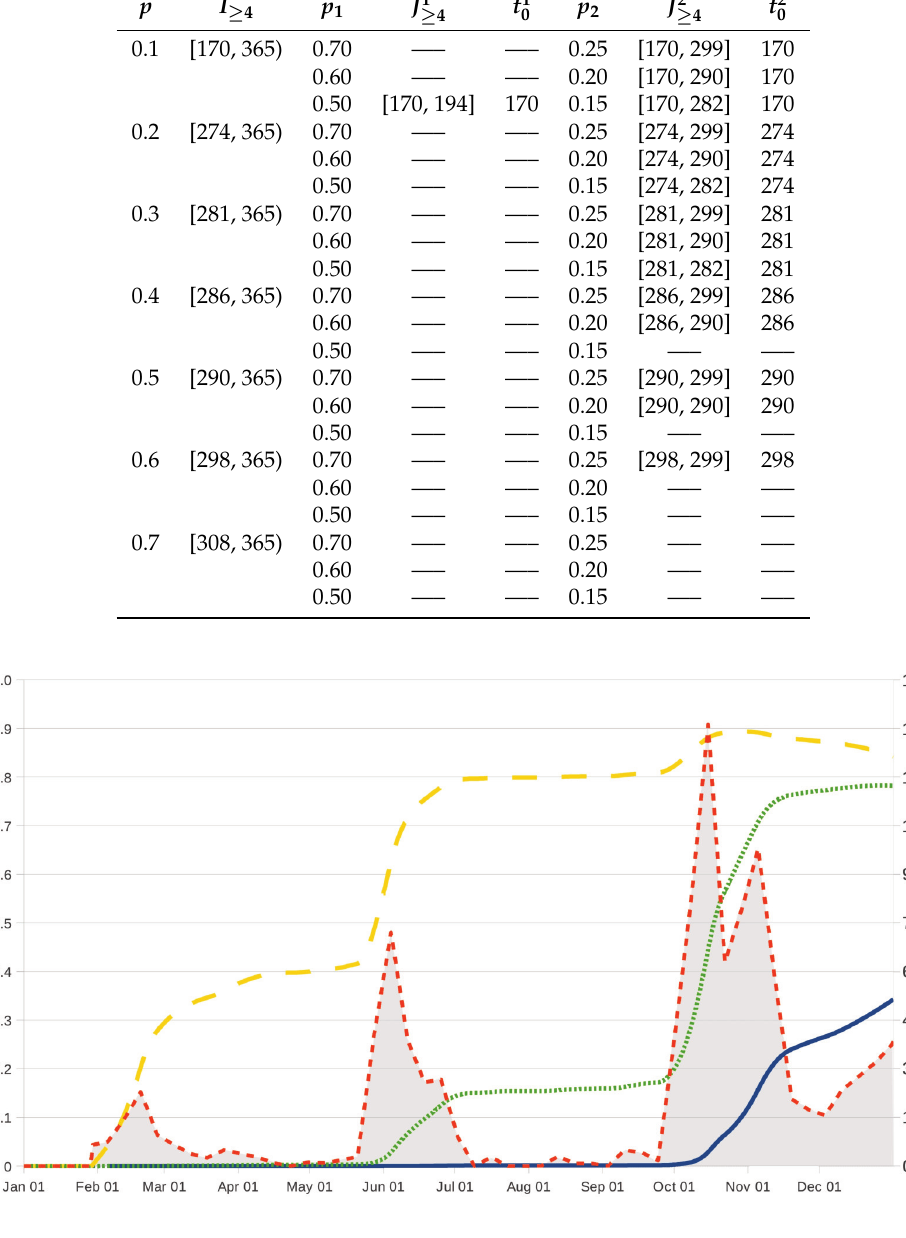
Figure A1. The age-dependent probability P ≥ m (cid:48) ( t ) as a function of the age t ∈ ( 0, τ ) with τ = 1 year, for m (cid:48) = 1 ( broken line), 4 ( dotted line) and 8 ( solid line), and increments in the number of L 3 infective larvae on the small intestine ( shaded area, right vertical